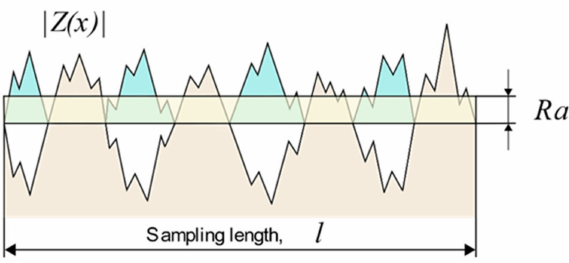
Figure 3. Scheme for the determination of the Ra roughness